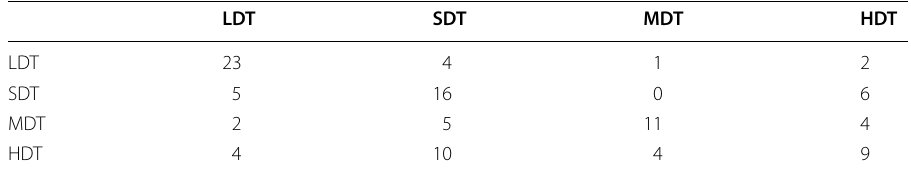
Table 6 Confusion matrix for the Decision Tree Predictor